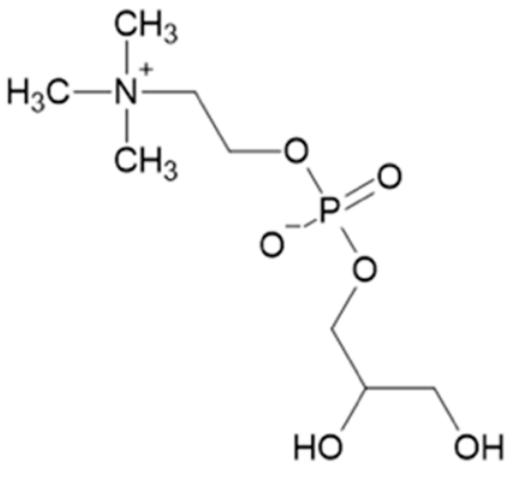
Figure 1. Chemical structure of α